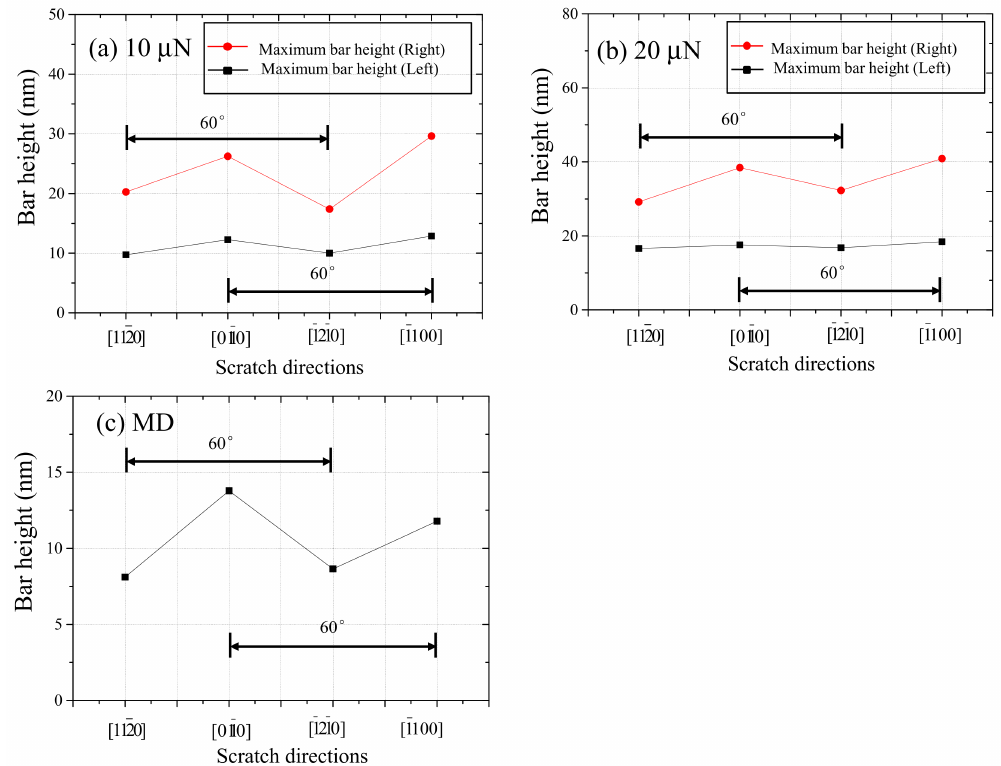
Figure 12. Comparison between experimental (( a ) 10 µ N, ( b ) 20 µ N) and ( c ) MD simulation results regarding the effect of scratching direction on burr